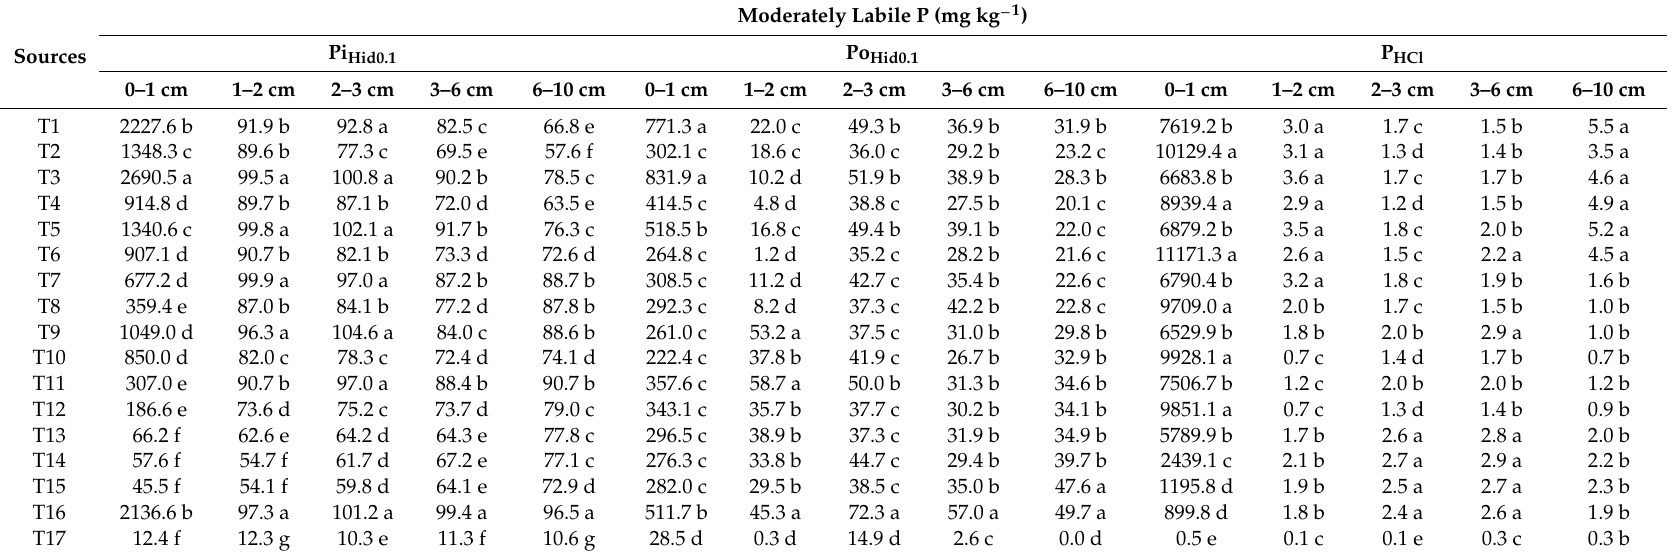
Table A3. Moderately labile fractions of inorganic and organic P in the soil extracted by 0.1 mol L − 1 NaOH (Pi Hid0.1 and Po Hid0.1 ) and 1 mol L − 1 HCl (P HCl ) in di ff erent layers of the columns in function sources of phosphate